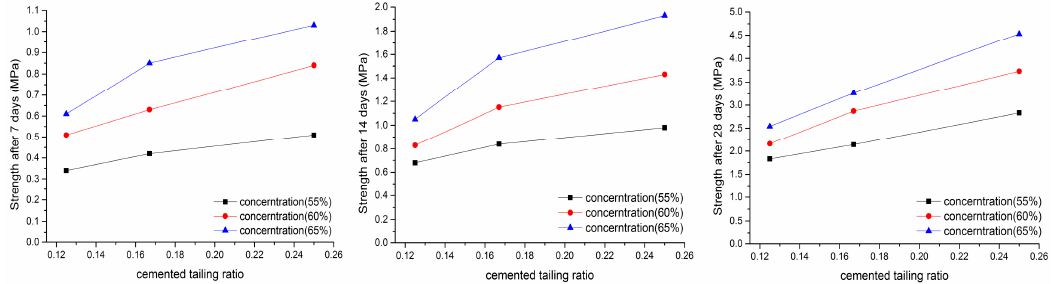
Figure 14. Results of backfill strength test.